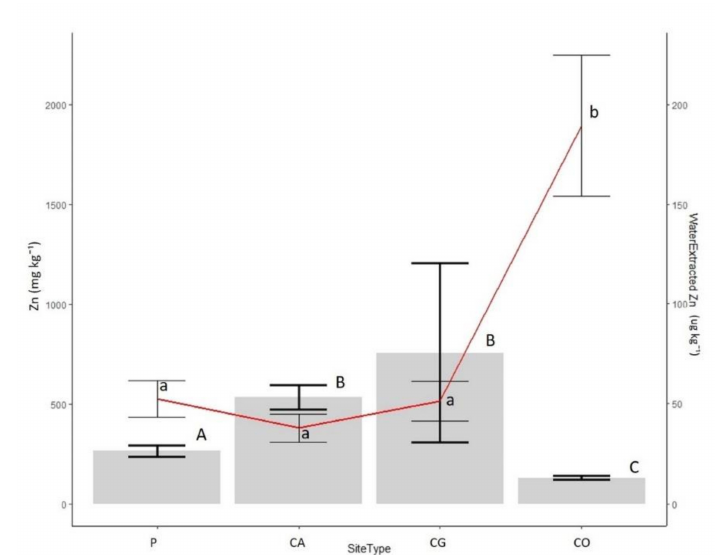
Figure 4. Site type total (mg kg − 1 , column: primary y axis) and water-extractable zinc concentrations ( µ g L − 1 , line: secondary y axis). Di ff erent letters denote significant mean di ff erence at p < 0.05. Error bars are ± 1